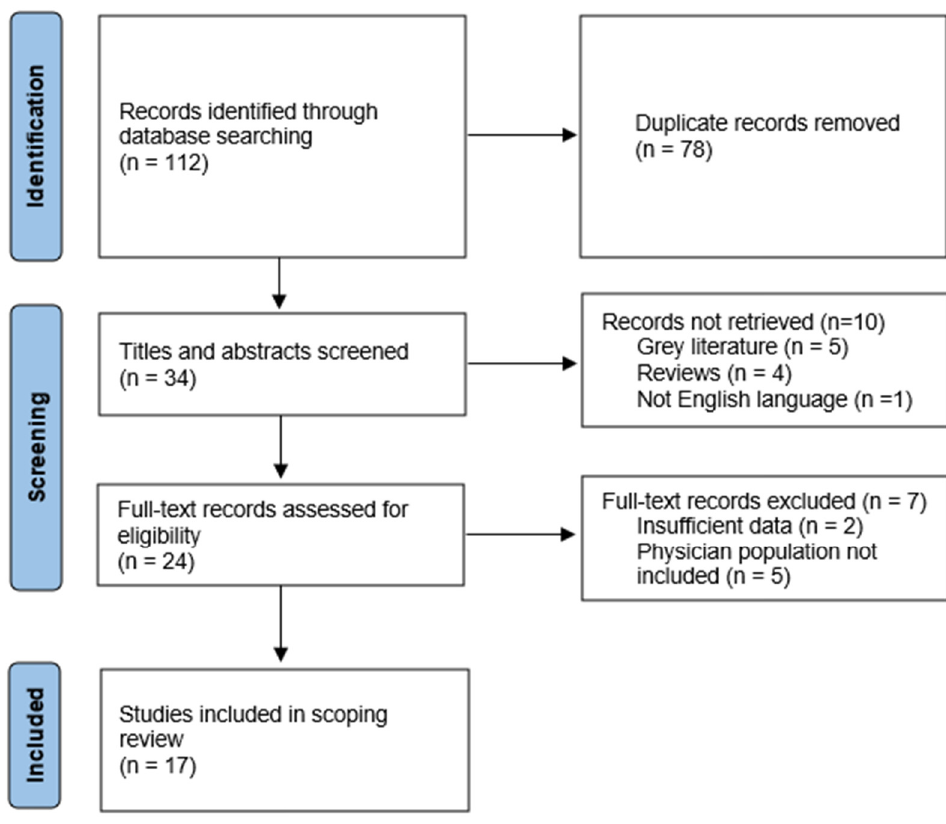
Figure 1. Flowchart of the literature search strategy and review process [59] (adapted from PRISMA 2020).